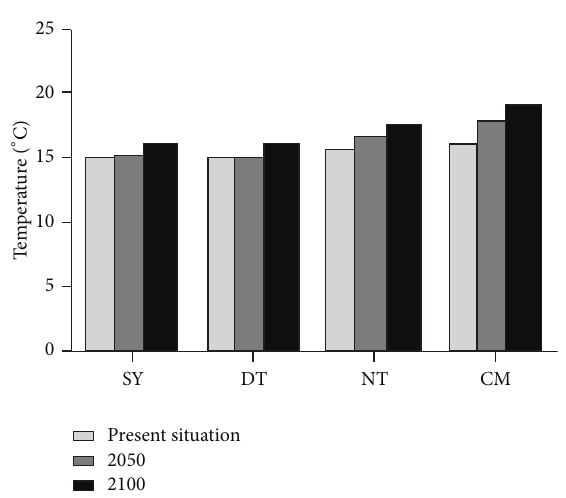
Figure 6: Comparison of present (average temperature of 80s and 00s) and future average annual temperature at different